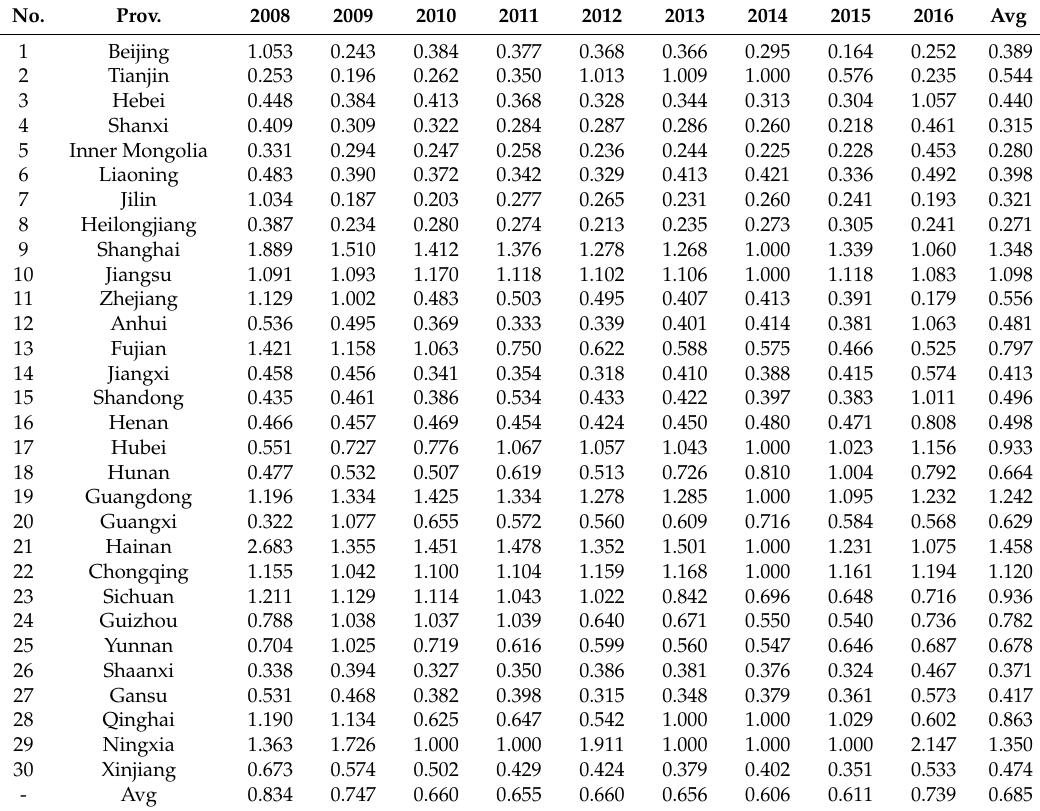
Table 1. Results of Chinese provincial community health service efficiency